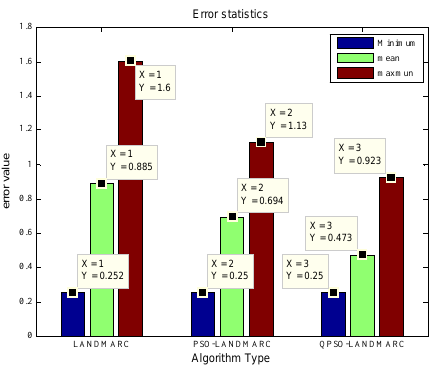
Figure 7. Localization error statistics.